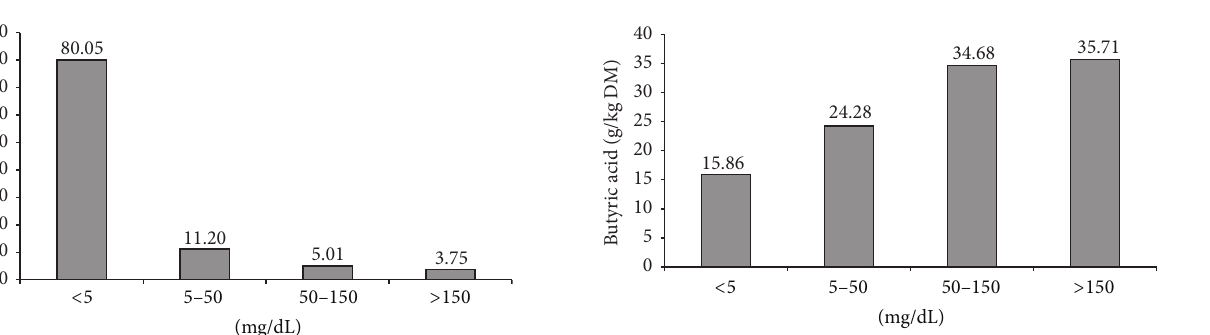
Figure1:Distributionfrequencyofcowsaccordingtoketonebodies content in urine (mg AcAc/dL): < 5mg/dL: trace; 5–50 mg/dL: low; 50–150 mg/dL: moderate; (subclinical ketosis: low + moderate); > 150mg/dL: high (clinical ketosis).